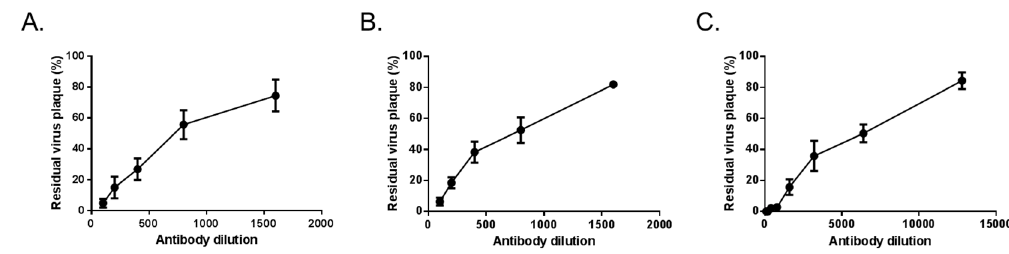
Figure 4. Neutralizing activity of anti-ZIKBeHMR-2 immune sera. Antibodies that neutralize ZIKBeHMR-2 were detected using a conventional PRNT. Plaque assay was performed on Vero cells. The residual virus plaques were defined as a percentage relative to the number of plaques in absence of serum. In ( A ), pooled immune sera ( n = 5) were collected at 1-week post-inoculation with a single dose of ZIKBeHMR-2 (5 log PFU). In ( B ), immune sera ( n = 5) were collected at 4-week post-inoculation with a single dose of ZIKBeHMR-2 (5 log PFU). In ( C ), immune sera ( n = 5) were collected at 10-week post-inoculation with two doses of ZIKBeHMR-2 (5 log PFU) with an interval of 6 weeks. Data are expressed as the mean ( ± SEM) from three independent